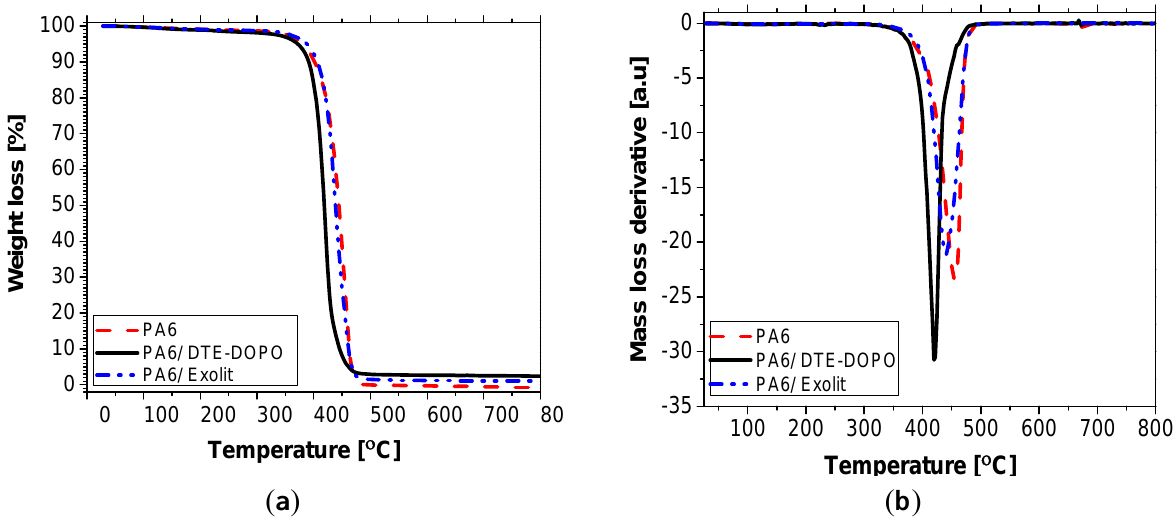
Figure 2. TGA ( a ) and DTG curves ( b ) of PA6 formulations in nitrogen.